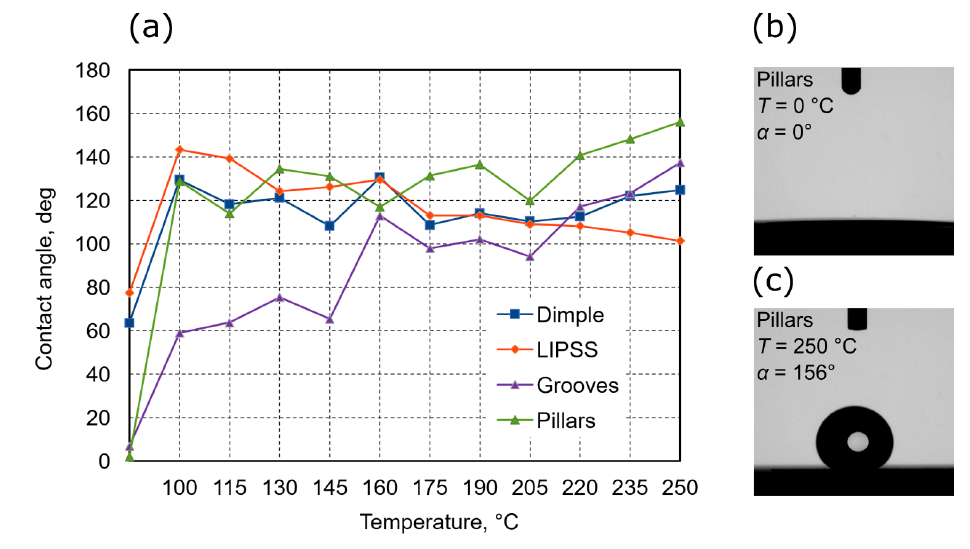
Figure 11. ( a )—The contact angle of different patterns on steel surface dependence heat treatment in different temperatures. ( b , c )—the lowest and highest acquired contact angle and temperatures needed to induce